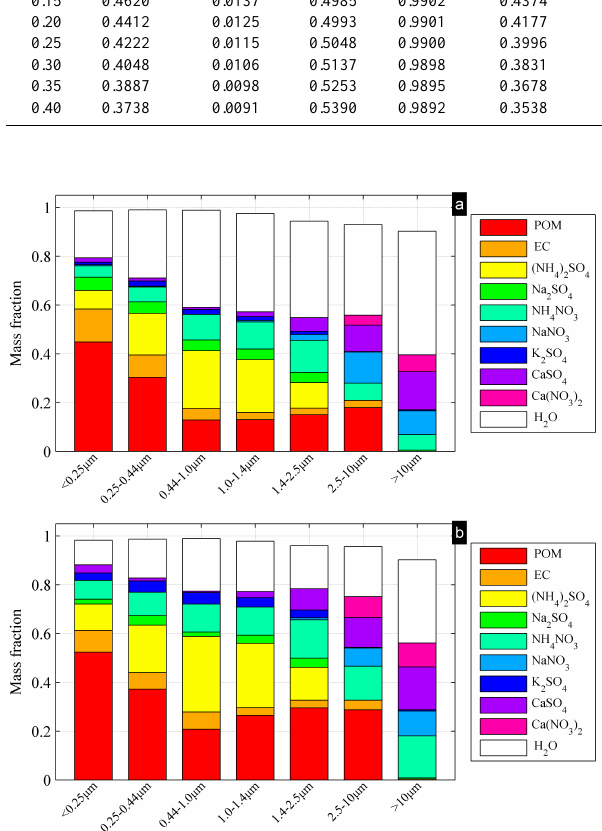
Figure 2 Mass fractions of the reconstructed major chemical constituents in different particle size ranges in wet (a) and dry (b) season.